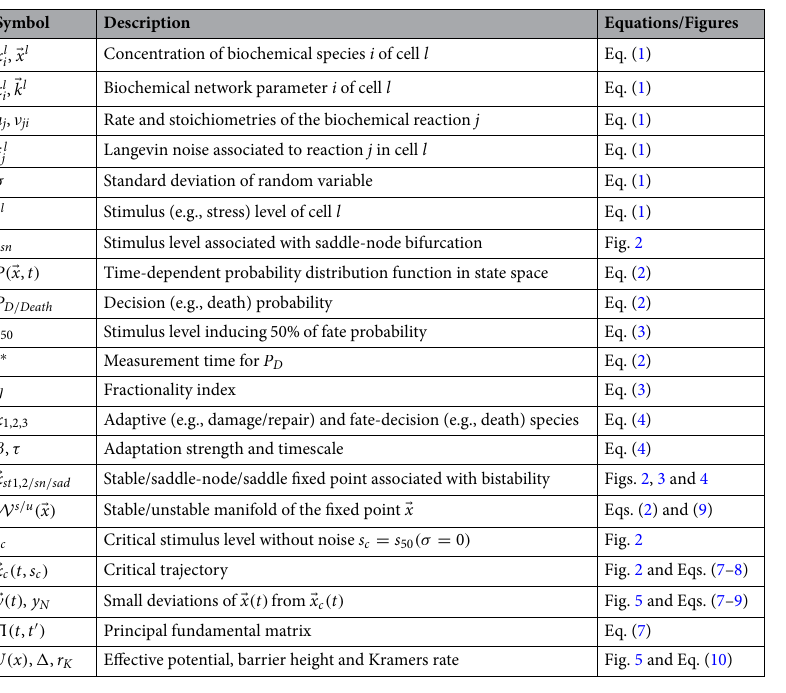
Table 1. List of mathematical symbols and